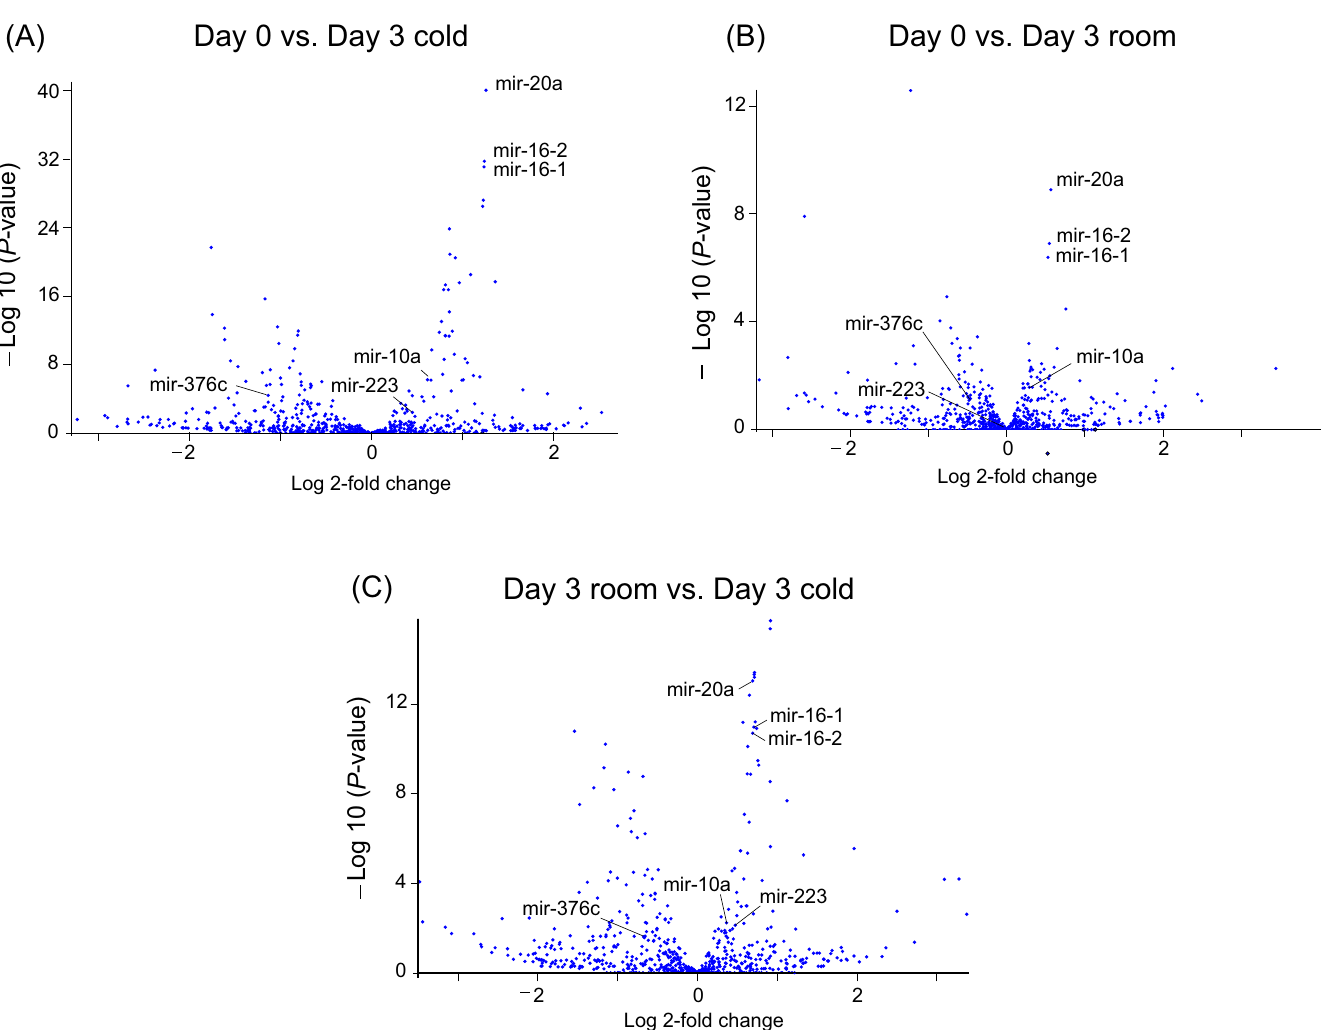
Fig 1. Volcano plots comparing changes in the expression of miRNAs between platelets exposed to baseline (Day 0), room-temperature (Day 3 room), and cold- storage (Day 3 cold) conditions.